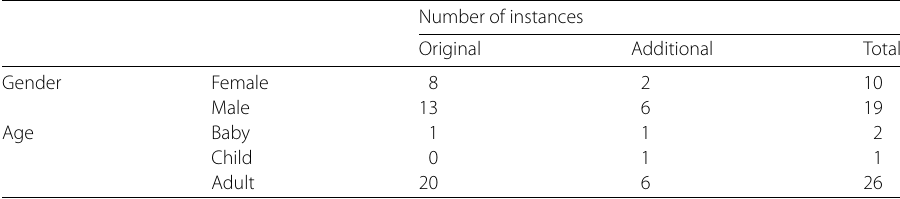
Table 13 Detailed description for the class “Person” of the training set regarding the characteristics gender and age